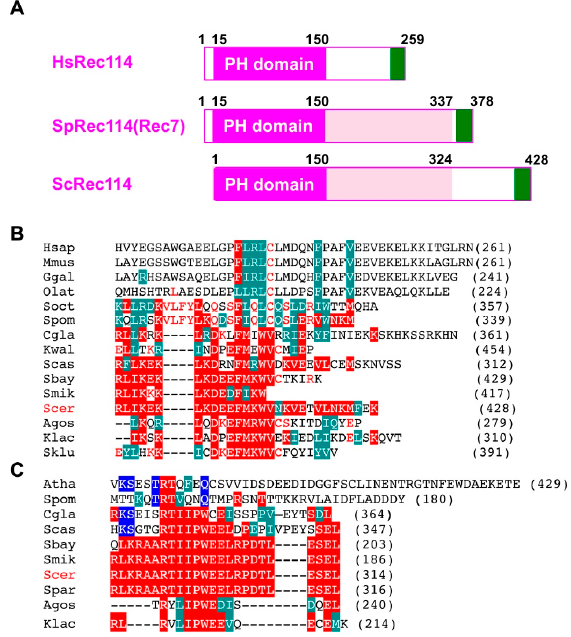
Figure 5. Sequence conservation of the C-terminal regions of Rec114 and Mer2. ( A ) Schematic comparison of human Rec114, fission yeast Rec114 (Rec7), and budding yeast Rec114. The PH domain is shown in a purple box. A newly identified conserved region of the C-terminus is shown in a green box. ( B ) Sequence alignment of a C-terminal region of the Rec114 orthologs from various species: H. sapiens , M. musculus , G. gallus , O. latipes (medaka), S. octosporus , S. pombe , C. glabrata , K. waltii , S. castellii , S. boyanus , S. mikatae , S. cerevisiae , S. paradoxus , A. gossypii , K. lactis , S. kluyveri . Alignment was produced by MUSCLE (http://www.drive5.com/muscle/) and is shown in CLUSTALW format. Identical and homologous amino acids with ScRec114 are shown in red and green boxes, respectively. Identical amino acids with SpRec114 (Rec7) are shown in red letters. ( C ) Sequence alignment of a C-terminal region of the Mer2 ortholog from various species: A. thaliana , S. pombe , C. glabrata , S. castellii , S. boyanus , S. mikatae , S. cerevisiae , S. paradoxus , A. gossypii , K. lactis . Identical and homologous amino acids with ScMer2 are shown in red and green boxes, respectively. Alignment was produced by MUSCLE program and is shown in CLUSTALW format as shown in ( B ). Identical amino acids with Arabidopsis Mer2 (PRD3) are shown in blue